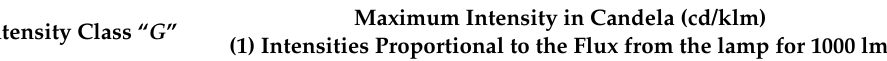
Table 2. G classes of luminous intensities of luminaires according to EN 13201-2:2015 (road lighting; performance requirements).